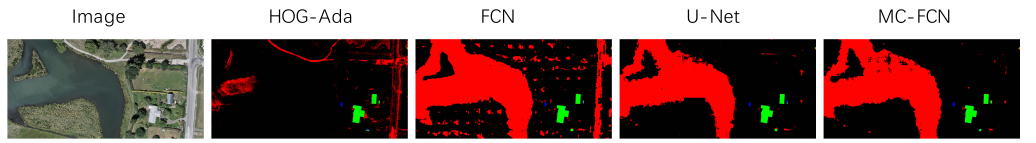
Figure 10. Zoomed-in image of the middle-left corner of the Test-1 region in Figure 4, where a small lake was misclassified as a building by all CNN-based methods. The green, red, blue and black pixels denote the predictions of true positive, false positive, false negative and true negative,